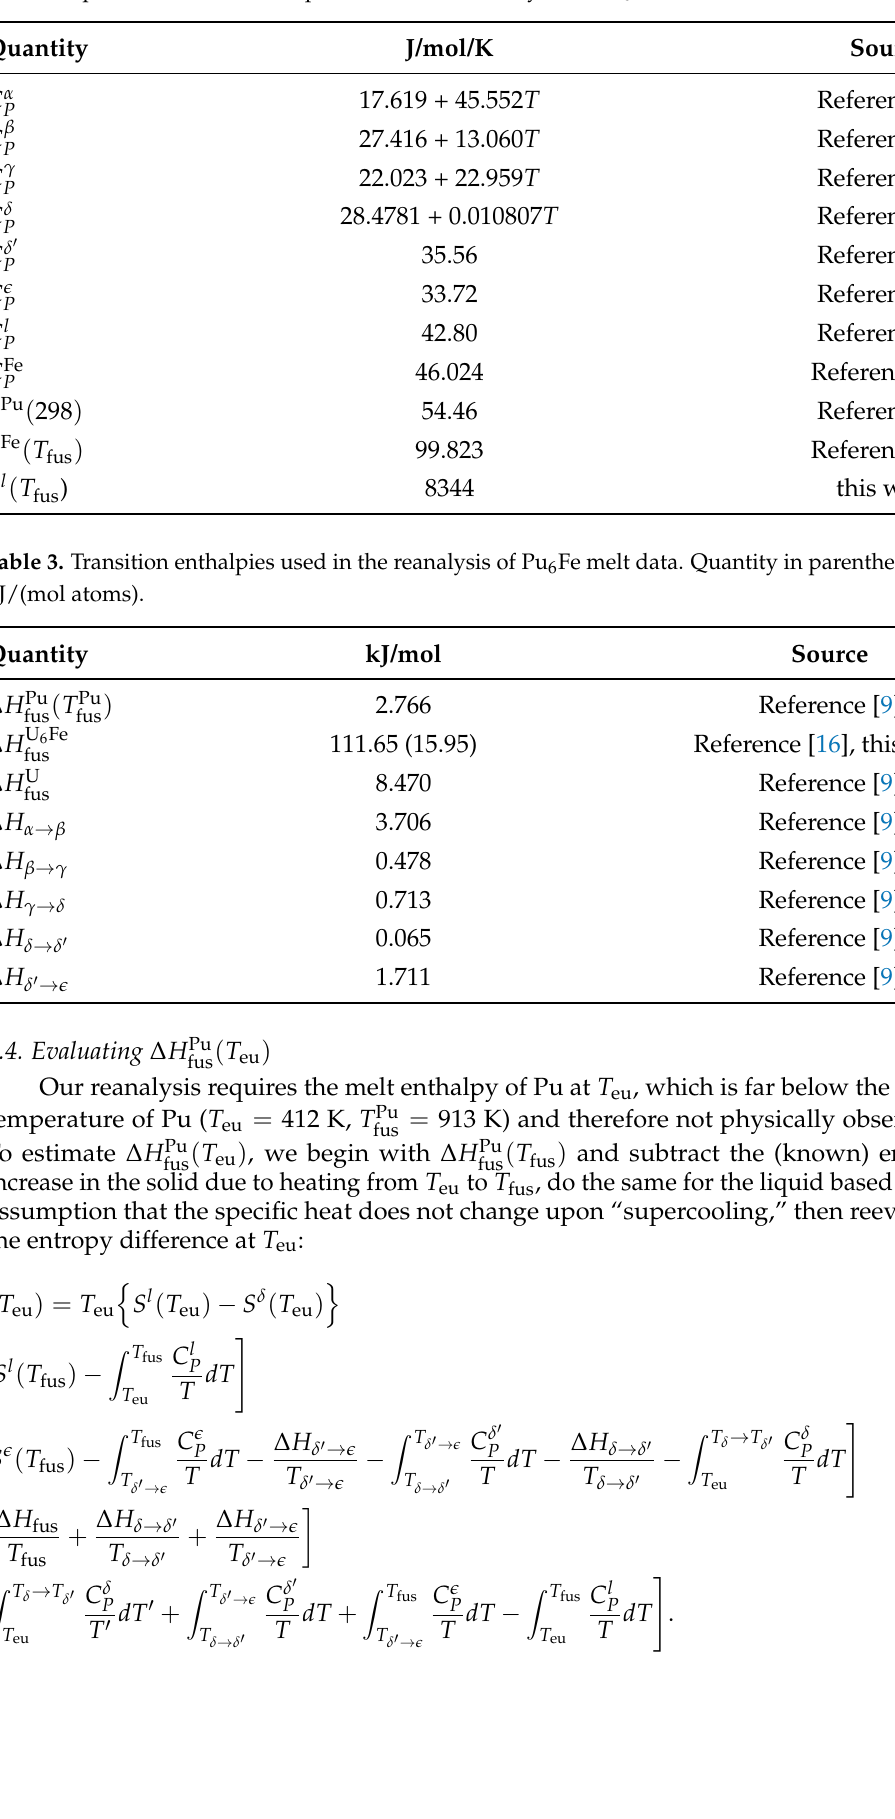
Table 2. Specific heats and entropies used in the reanalysis of Pu 6 Fe melt data.